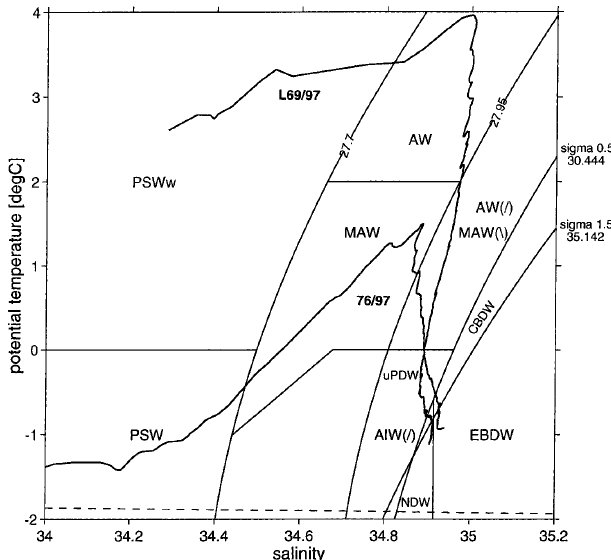
Fig. 2. Restrictions to be fulfilled by the di(cid:128)erent water masses. The definitionsare based onFriedrich et al .(1995) and Rudels et al .(1999). PSW (Polar Surface Water), r < 27.70, Q < 0 (cid:176) C; PSWw (Polar 0 Surface Water warm, essentially ice melt water above the Atlantic Water), r < 27.70, 0 (cid:176) C < Q ; AW (Atlantic Water from the south), 0 27.70 < r < 27.97, 2 (cid:176) C < Q , or 27.97 < r , and r < 30.444, 0 0 0.5 0 (cid:176) C < Q , and the water column unstable in the finger sense; MAW (Modified Atlantic Water from the Arctic Ocean) 27.70 < r